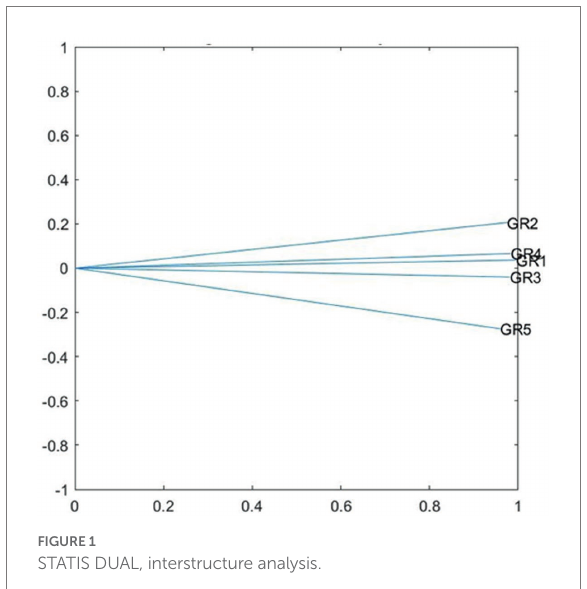
FIGURE 1 STATIS DUAL, interstructure